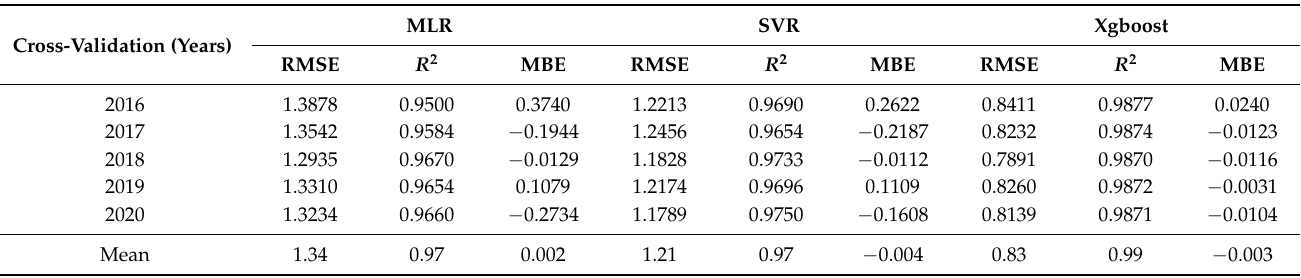
Table 3. Detailed cross-validation results.